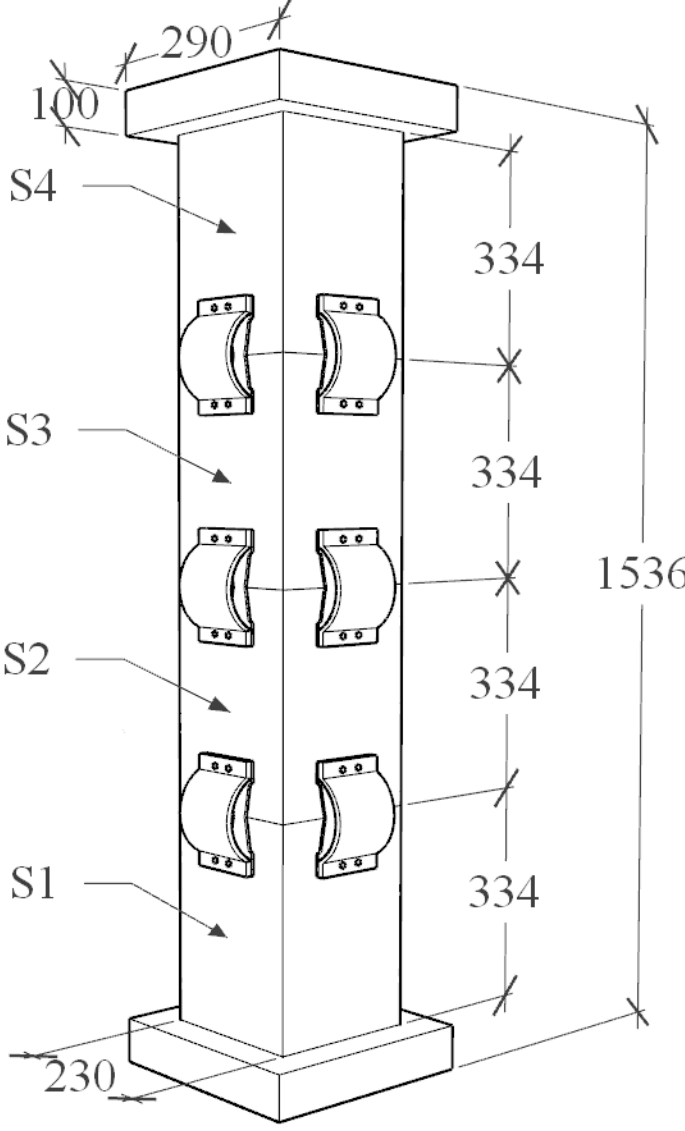
Figure 10. Structure of precast assembled pier test piece (unit: mm). The loading mode of each specimen is low-cycle reciprocating loading, the loading position is at the side center of the pier cap, and the bottom of the pier column is fully constrained to form a cantilever structure. The loading mode adopts displacement control, and the horizontal offset rates of the pier top are 0.07%, 0.13%, 0.20%, 0.27%, 0.34%, 0.67%, 1.01%, and 1.35%, respectively. Each stage of loading cycles twice, and the loading curve is shown in Figure